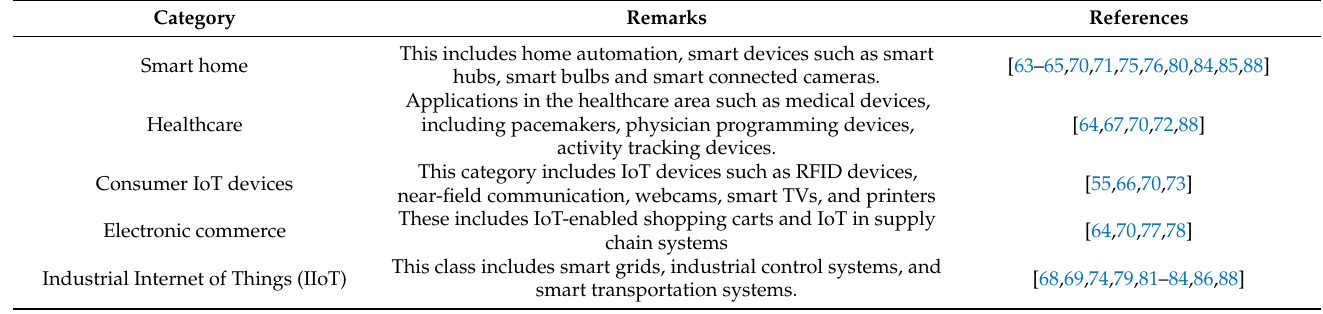
Table 7. Application domains used in the articles.